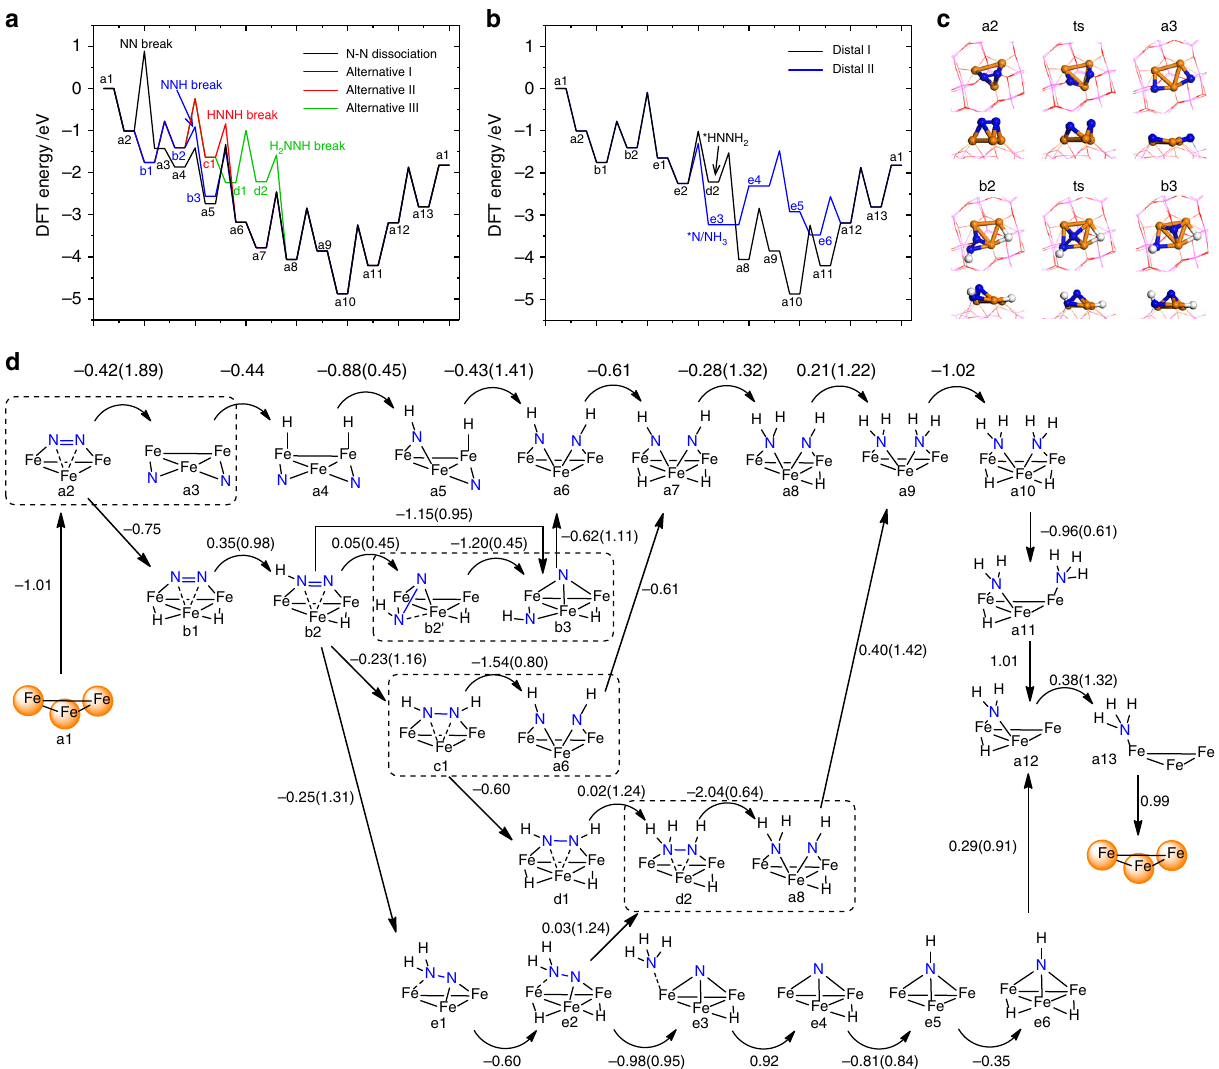
Fig. 3 Energy diagrams for ammonia synthesis. a The dissociative mechanism, and three pathways of associative mechanism with N – N bond dissociation at *NNH, *HNNH, and *HNNH 2 intermediates by the alternating hydrogenation route. b Two pathways of associative mechanism by the distal hydrogenation route. c Initial, transition, and fi nal states of *N 2 and *NNH dissociation step. d Schematic depiction of the six reaction pathways for conversion of N 2 to NH 3 catalyzed by Fe 3 / θ -Al 2 O 3 (010). Reaction energies are shown for every step and barriers are enclosed in brackets. The dissociation steps of *N 2 , *NNH, *HNNH, and *HNNH 2 intermediates are enclosed with dashed